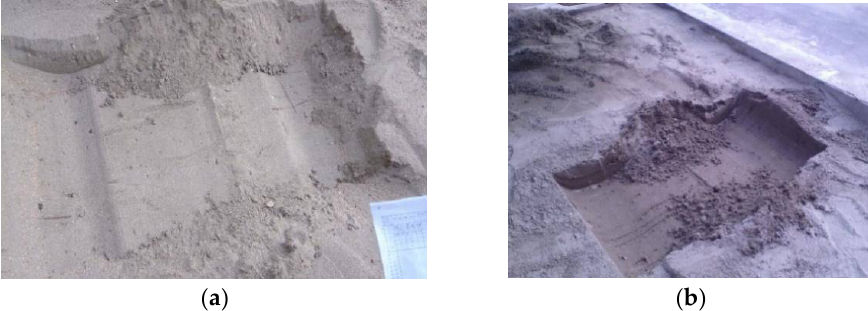
Figure 18. Flat digging test: ( a ) Dry sand for test, ( b ) Wet soil for test.